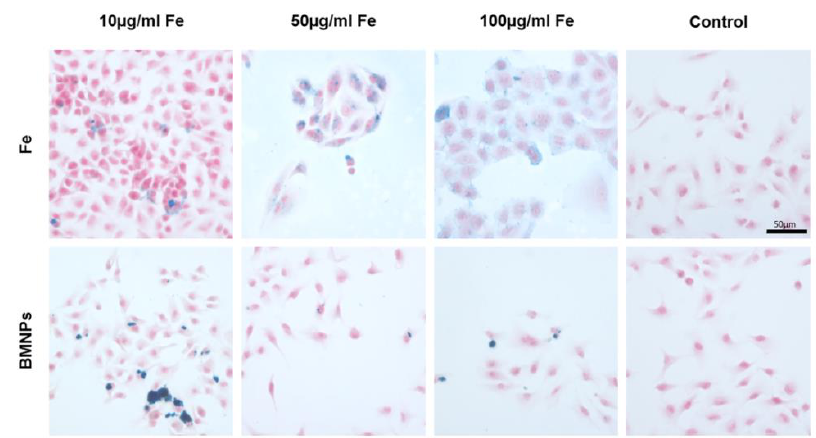
Figure 5. Internalization of BMNPs in colon cancer cells. Representative images of T-84 human cancer cells exposed to different concentrations of BMNPs and Fe and stained with Prussian blue.